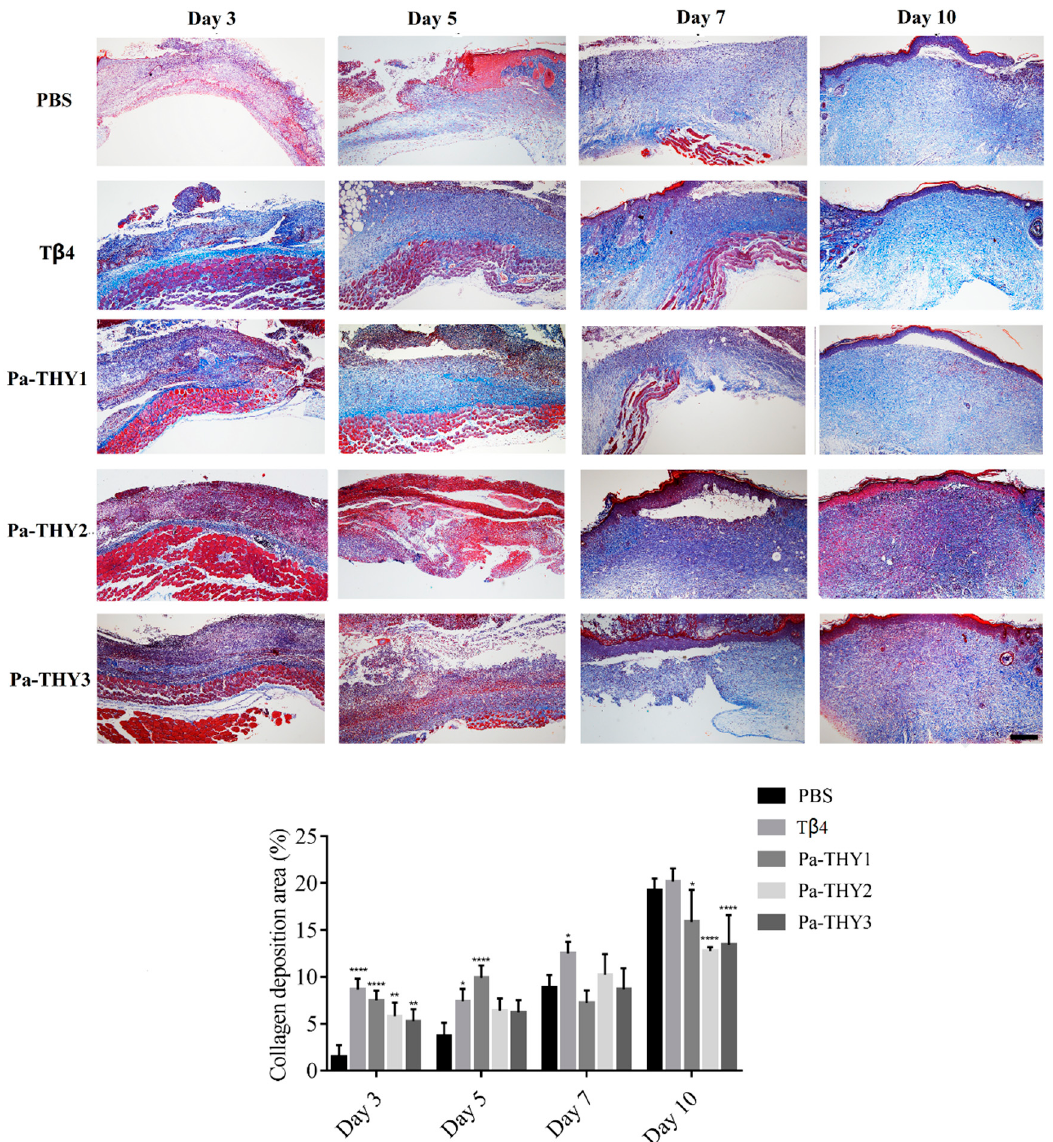
Figure 8. Masson staining of wound areas in dermal tissues treated with T β 4 and Pa-THYs proteins (Scale bar = 500 µ m, × 40). All the groups compared to PBS group in certain time point, two-way ANOVA analysis, * p < 0.05; ** p < 0.01; **** p < 0.0001.